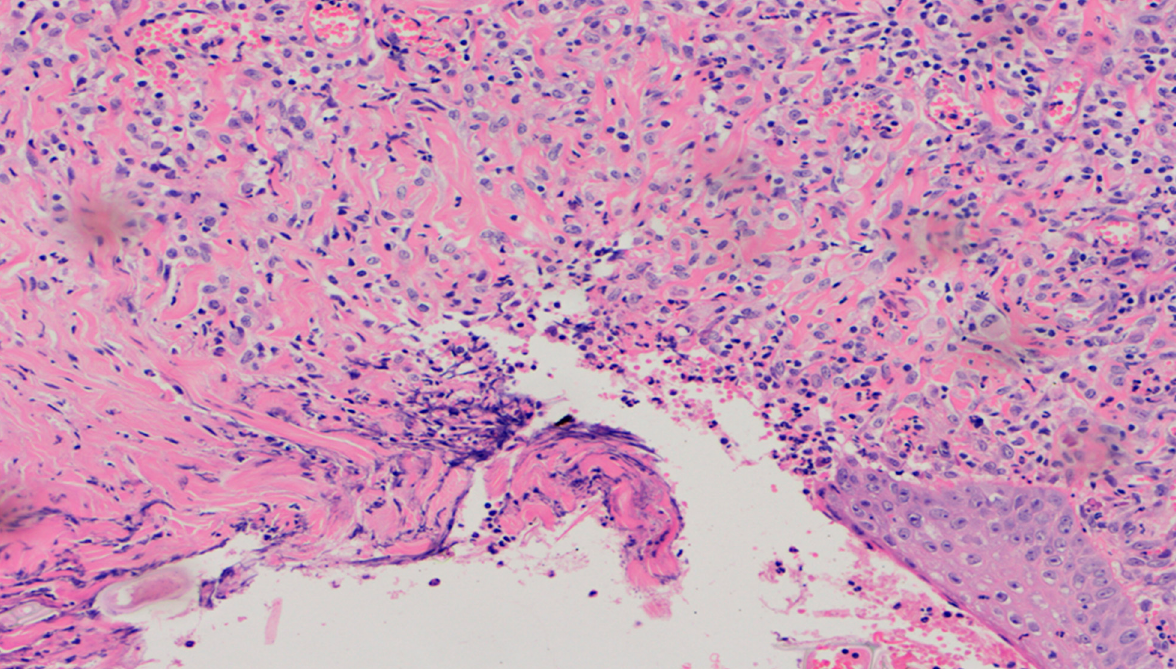
Figure 23. Dermis, under the ulceration with mixed (lymphocyte-predominant) inflammatory infiltration, low density, with polynuclear giant cell of foreign body type (100×, H-E), in the wound treated with sulfathiazole, on day 25.